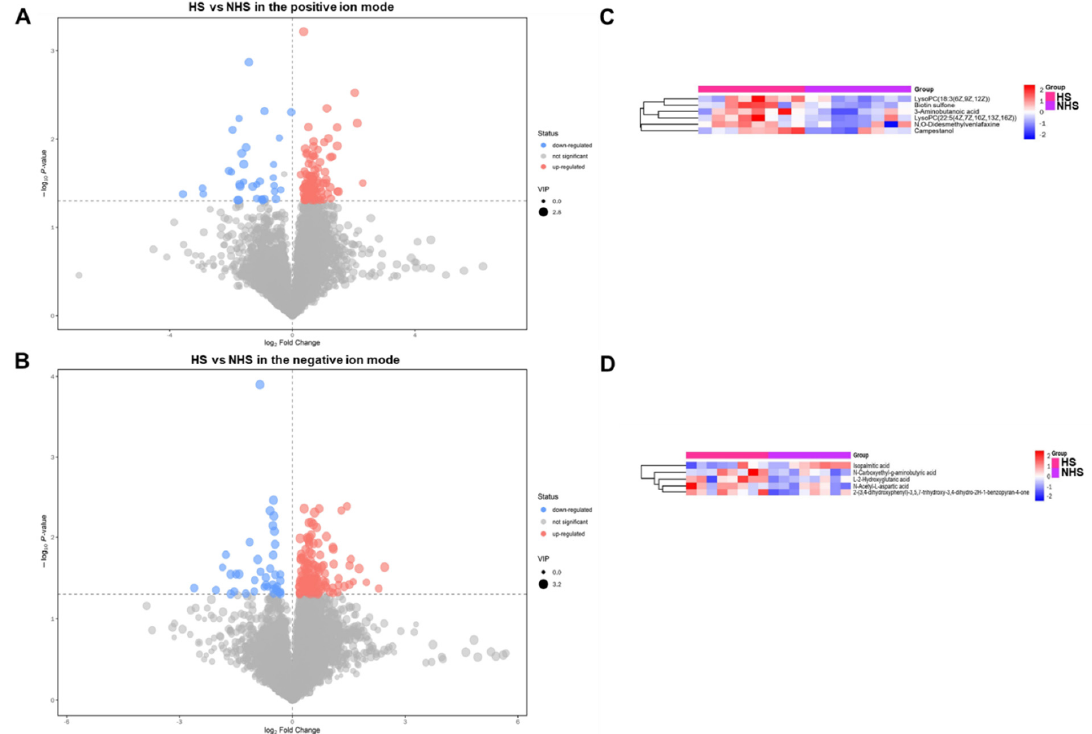
Figure 4. Differential expression and cluster analysis of metabolites between HS and NHS group. ( A , C ) Volcano plot of sperm metabolites identified in the positive and negative ion modes. The plots were used to display changes of metabolites between HS and NHS groups. The red circles represent up-regulated metabolites, the blue circles represent down-regulated metabolites, and the gray circles represent no changes of metabolites. ( B , D ) Heat map of sperm metabolites identified in the positive and negative ion modes. The heat maps were used to visualize the dynamic changes of metabolite content between HS and NHS groups. The pink represents HS group, and the purple represents NHS group. The color scale of the heatmap represents the gradual decrease of metabolite content from red to blue.